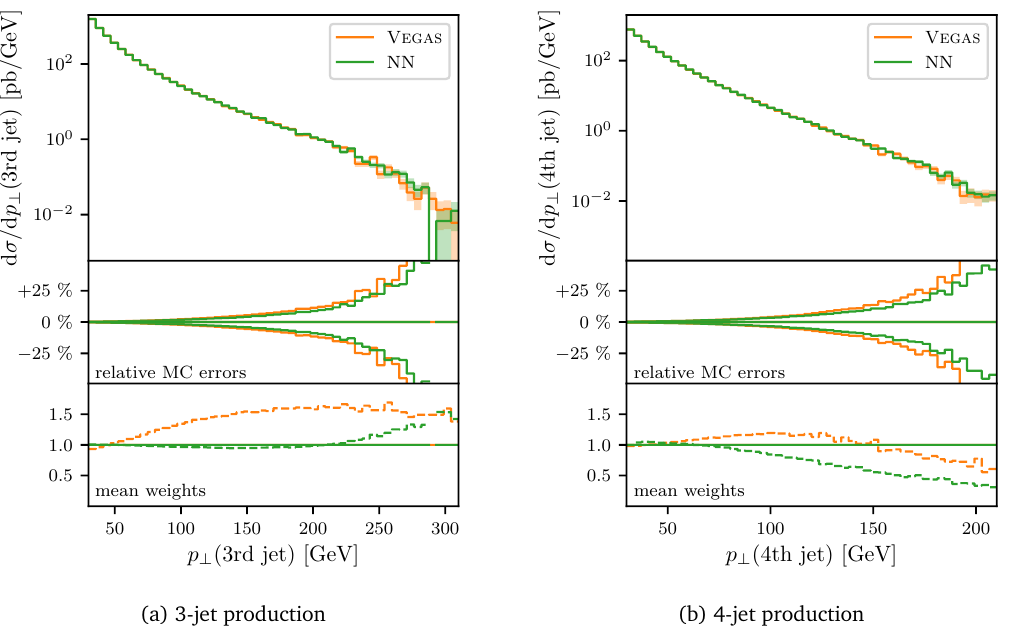
Figure 5: The transverse momentum of the smallest- p ⊥ jet in three-gluon production (left) and in four-gluon production (right). For both observables, we compare the nominal distributions for a V EGAS -optimised and a NN-optimised phase space sam- pling (upper panes). In the middle panes, Monte Carlo errors for both samples are compared. The lower panes show the mean event weights per